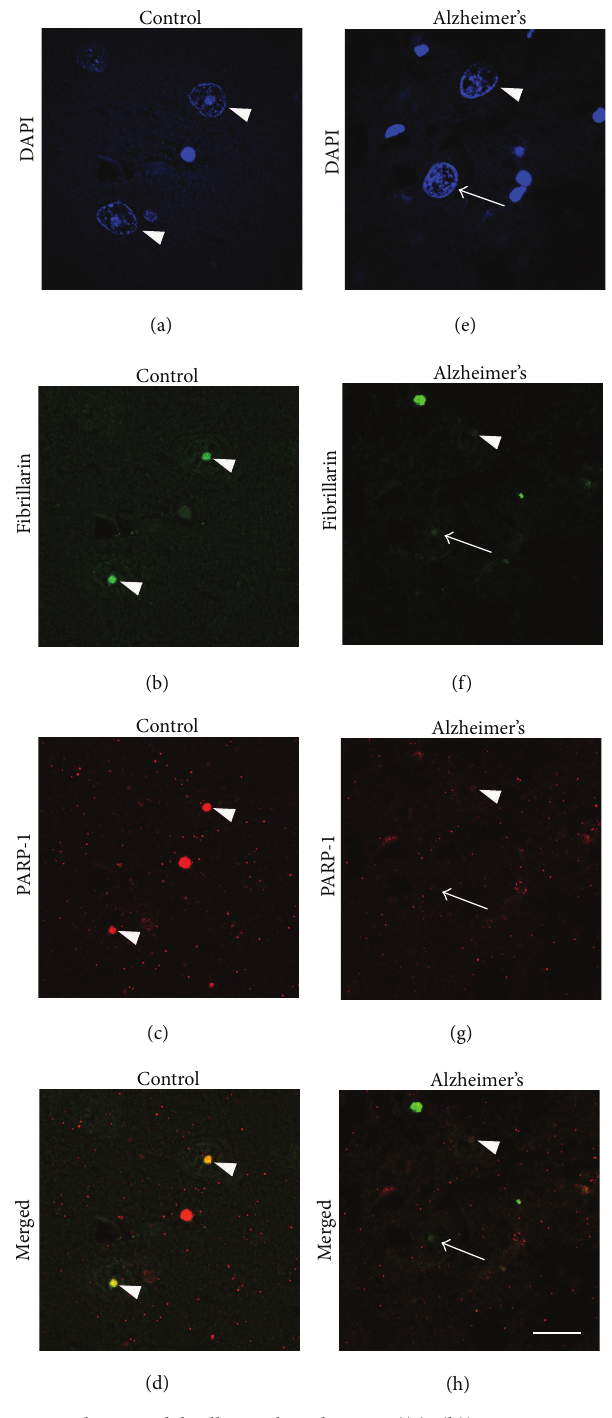
Figure 3: Nucleolar proteins in hippocampal pyramidal cells are altered in AD. ((a)–(h)) Representative figures show colocalization ((d) and (h), yellow) of fibrillarin ((b) and (f), green) and PARP-1 ((c) and (g), red) in the nucleoli of pyramidal neurons. Control cases exhibit high intensity staining (a–d) compared to AD (e–h) (arrowheads). In AD compared to controls, there is a lower percentage of nucleoli that are both PARP-1(+) and fibrillarin(+) ((f)-(g), arrowhead) in CA1 (see Table 2) and CA4 (see Table 3) pyramidal cells and a higher percentage of nucleoli PARP-1( − )/fibrillarin(+) ((f) and (g), arrow) in CA1 (see Table 2) and CA4 (see Table 3), suggesting that different nucleolar proteins are affected in different ways in AD. Scale bar = 20 𝜇